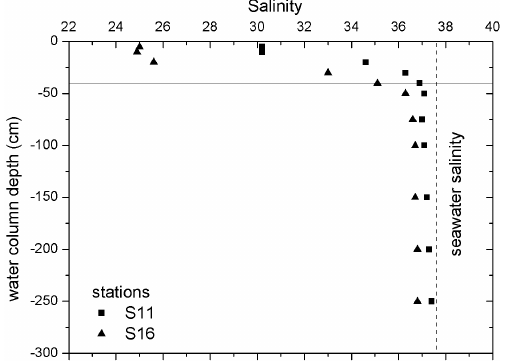
Fig. 3. Salinity profiles evidencing a fresher, less dense layer of 40cm in June 2007.